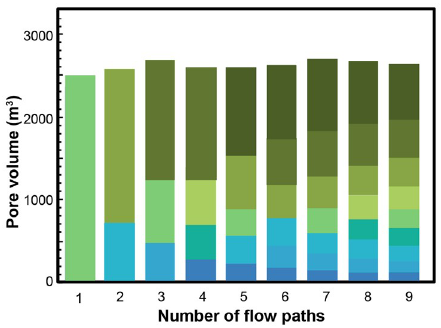
Figure 13. Pore volume calculated from tracer response curve from Balcova geothermal field.